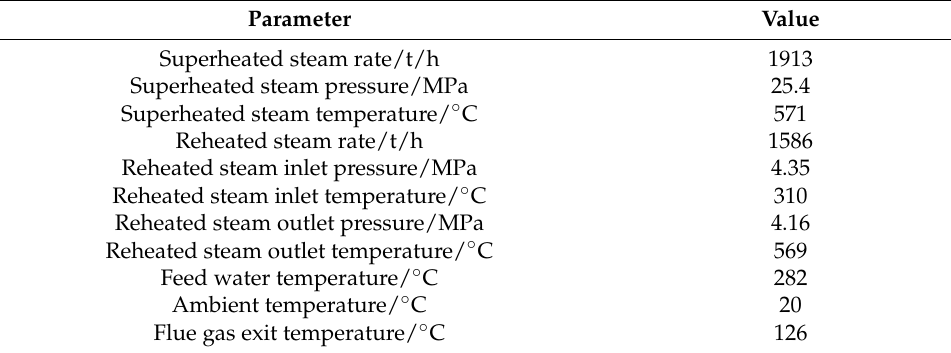
Table 2. Designed thermal parameters of the